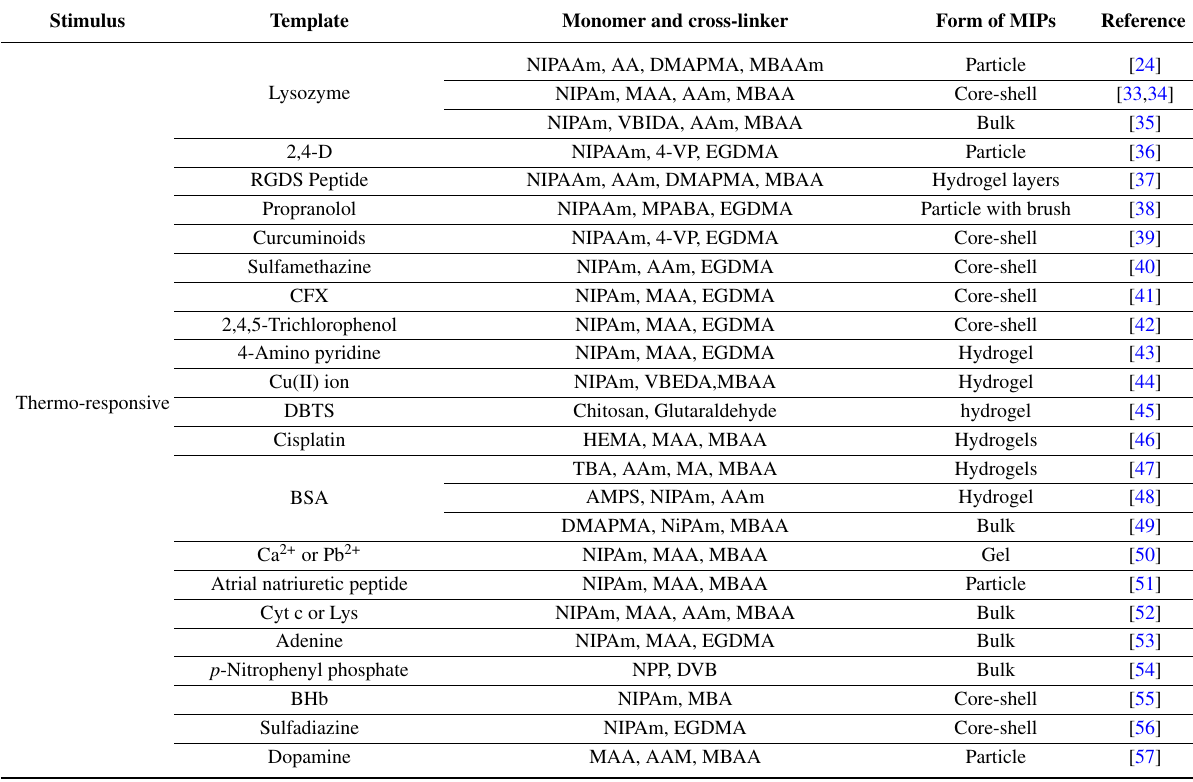
Table 1. Overview of different responsive